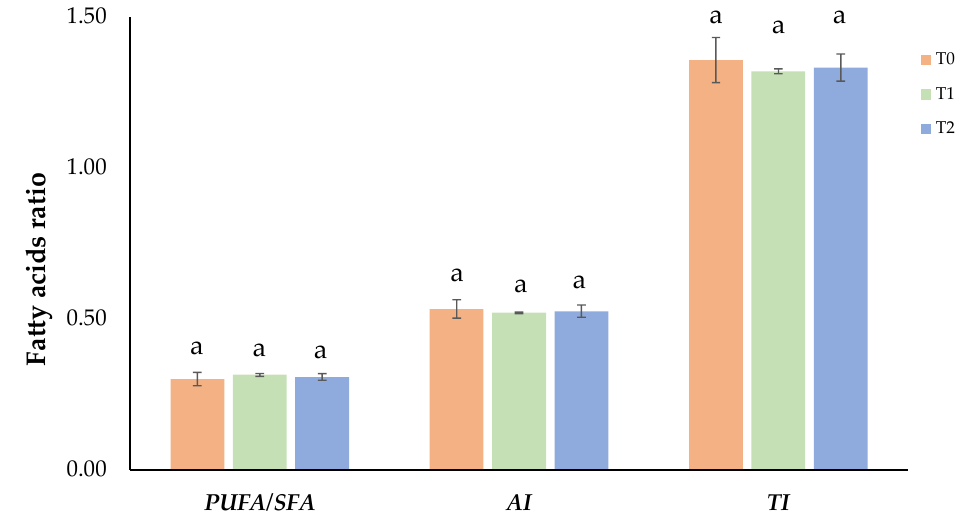
Figure 2. Fatty acid ratios and nutritional indices of the frankfurters. T0 (frankfurter prepared without antioxidant), T1 (frankfurter prepared with Plus Color) and T2 (frankfurter prepared with murta as antioxidant). Different letters indicate a significant difference between treatments ( p ≤ 0.05; Tukey test). Error bars correspond to standard error.